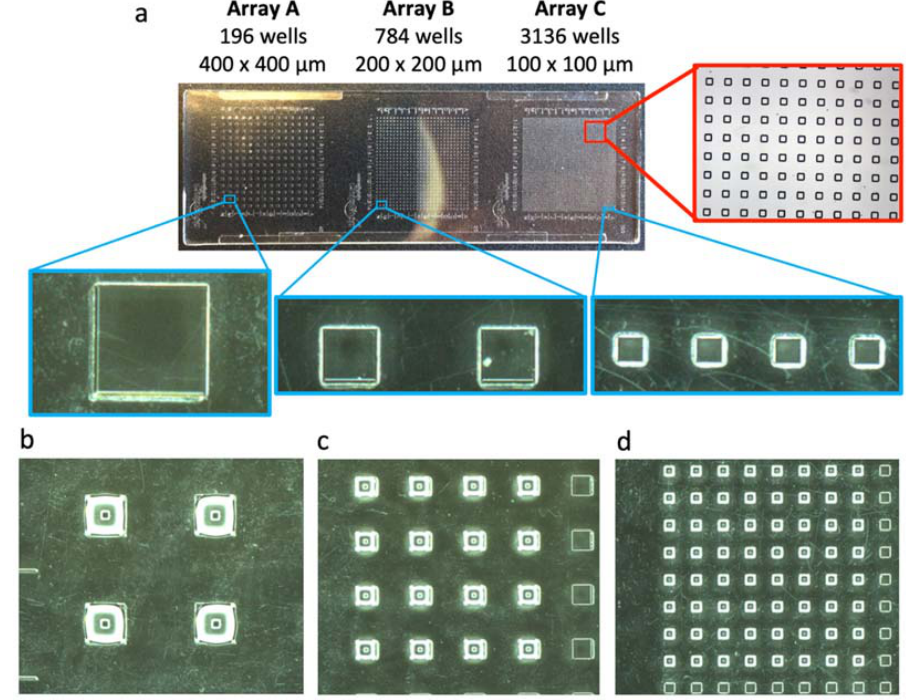
Figure 3. Optimization of piezo printing into microwells. ( a ) Commercial microtiter plate (Microfluidic ChipShop, Jena, Germany) containing three microwell arrays with square microwells of varying